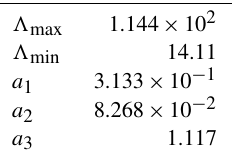
Table 1. Parameter values used in Eq.